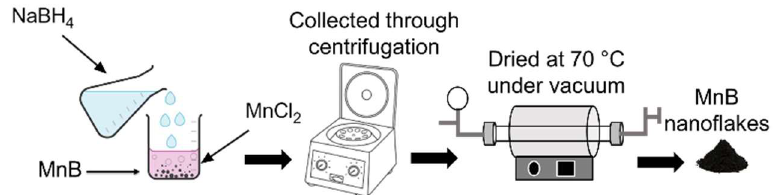
Figure 1. Synthesis procedure for the MnB nanoflakes. Table 1. Synthesis description and sample names used in this